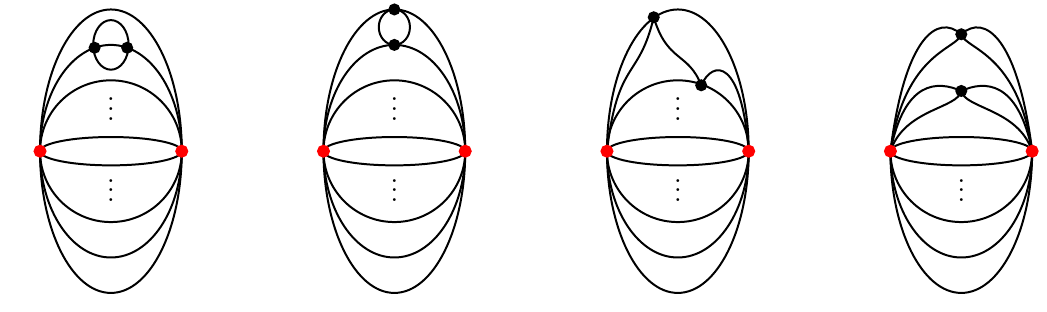
Figure 3 . Four topologies contributing at order O ( g 2 ).